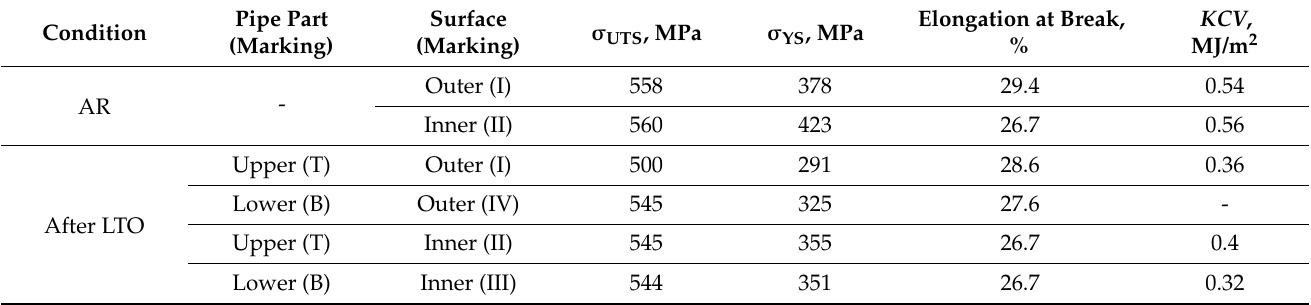
Table 2. Characteristics of strength ( σ UTS and σ YS ), plasticity ( elongation at break ), and impact